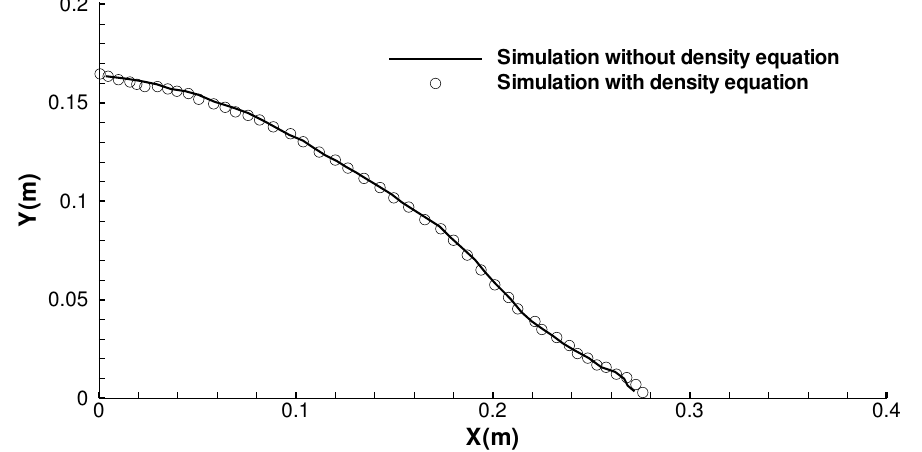
Figure 7. Numerical simulations of dry granular column collapse with and without continuity Equation (1). The slope profile at t = 0.3 s is shown. The initial granular column is 0.1 m wide and 0.2 m